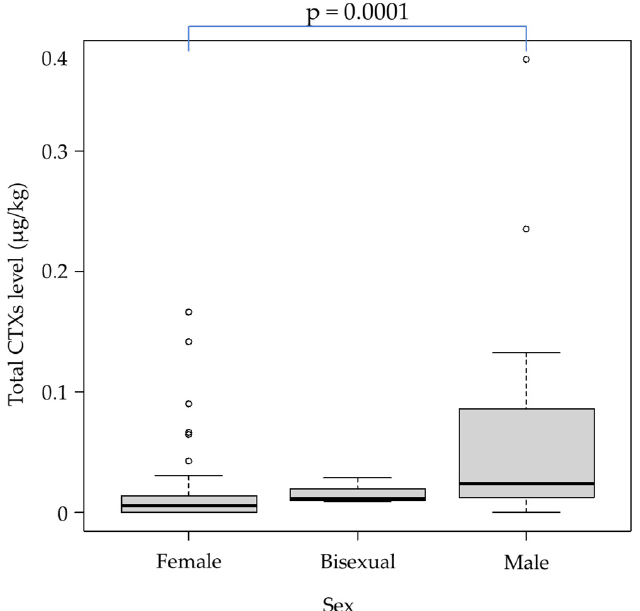
Figure 9. Compared total CTX levels in the flesh of V. louti specimens collected from Ryukyu Island, Japan, based on gender.